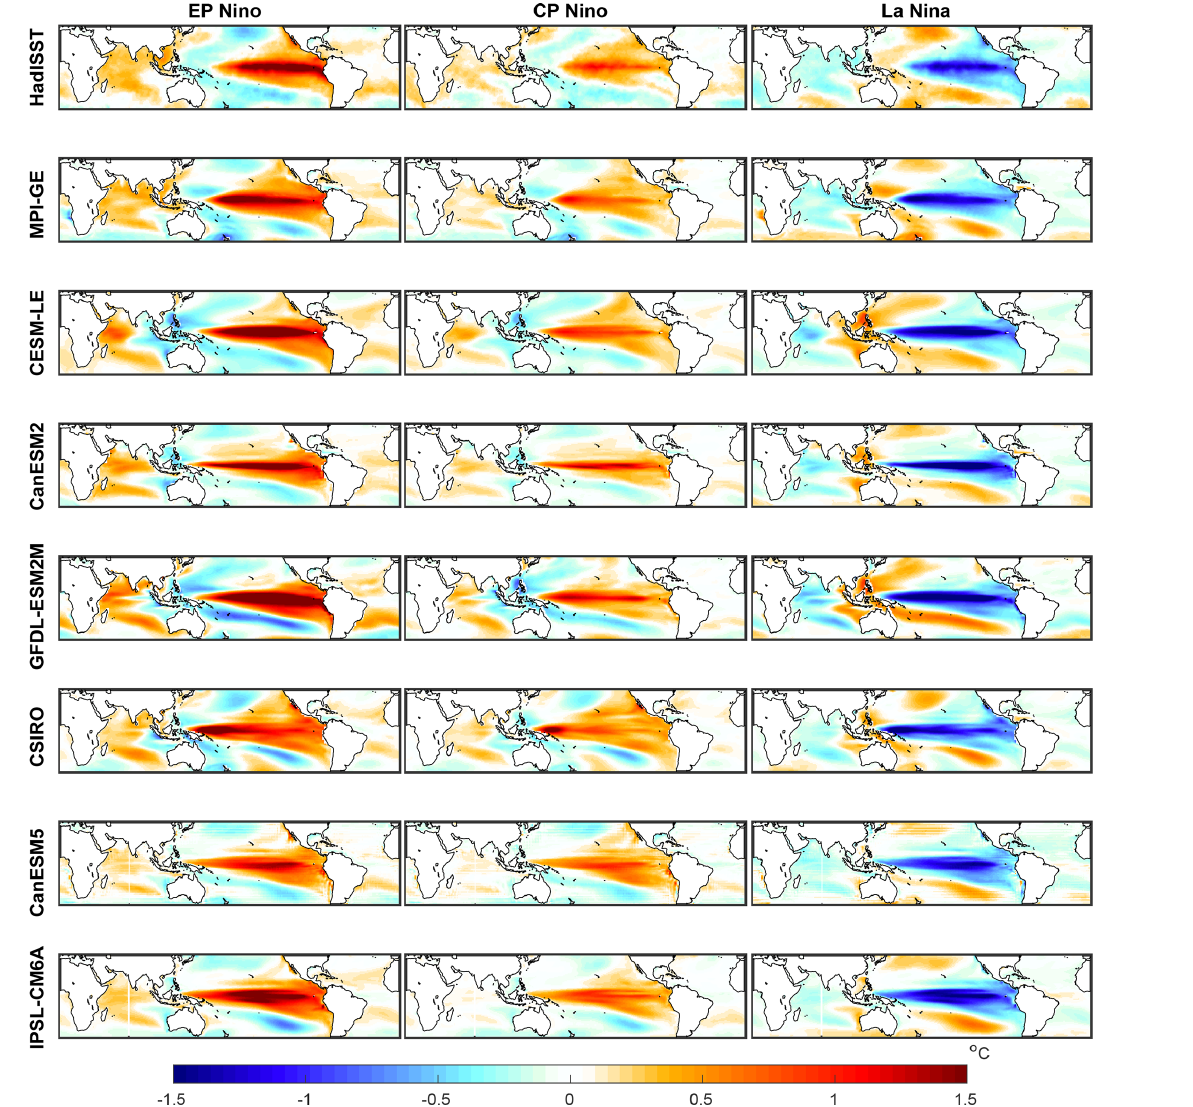
Figure 1. SST pattern for composites of EP and CP El Niño events and La Niña events (left, middle, and right columns respectively); shown for HadISST observations (top row) and each individual SMILE (in order of appearance: MPI-GE, CESM-LE, CanESM2, GFDL- ESM2M, CSIRO, CanESM5, and IPSL-CM6A). The SST pattern is shown for the November, December, January average. SMILE data have the forced response (ensemble mean) removed prior to calculation, HadISST is detrended using a second-order polynomial, and then each month’s average is removed. The time period used is all of the historical period, which is shown for the observations in Table S1 and SMILEs in Table